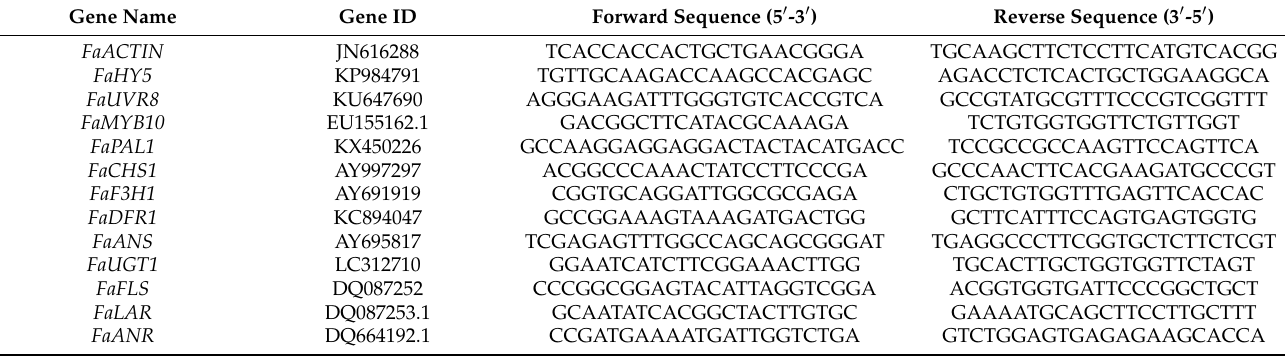
Table 1. List of primers used for gene expression